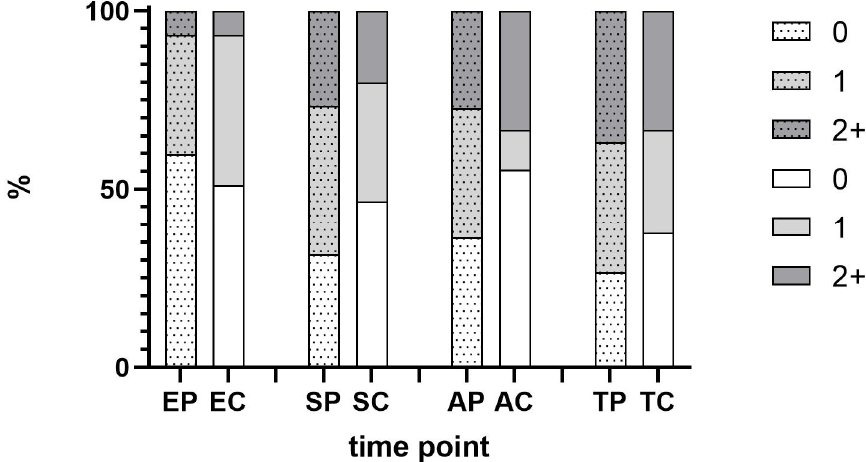
Figure 2. Scores attributed by the 20 practitioners for parents (P: Parents, shaded columns) and children (C: Children, open columns). The scores were given at entrance in the office (E: Entrance), installation and seating (S: Seating), administration of local anesthetic (A: Administration, n = 11 cases), and treatment (T: Treatment).